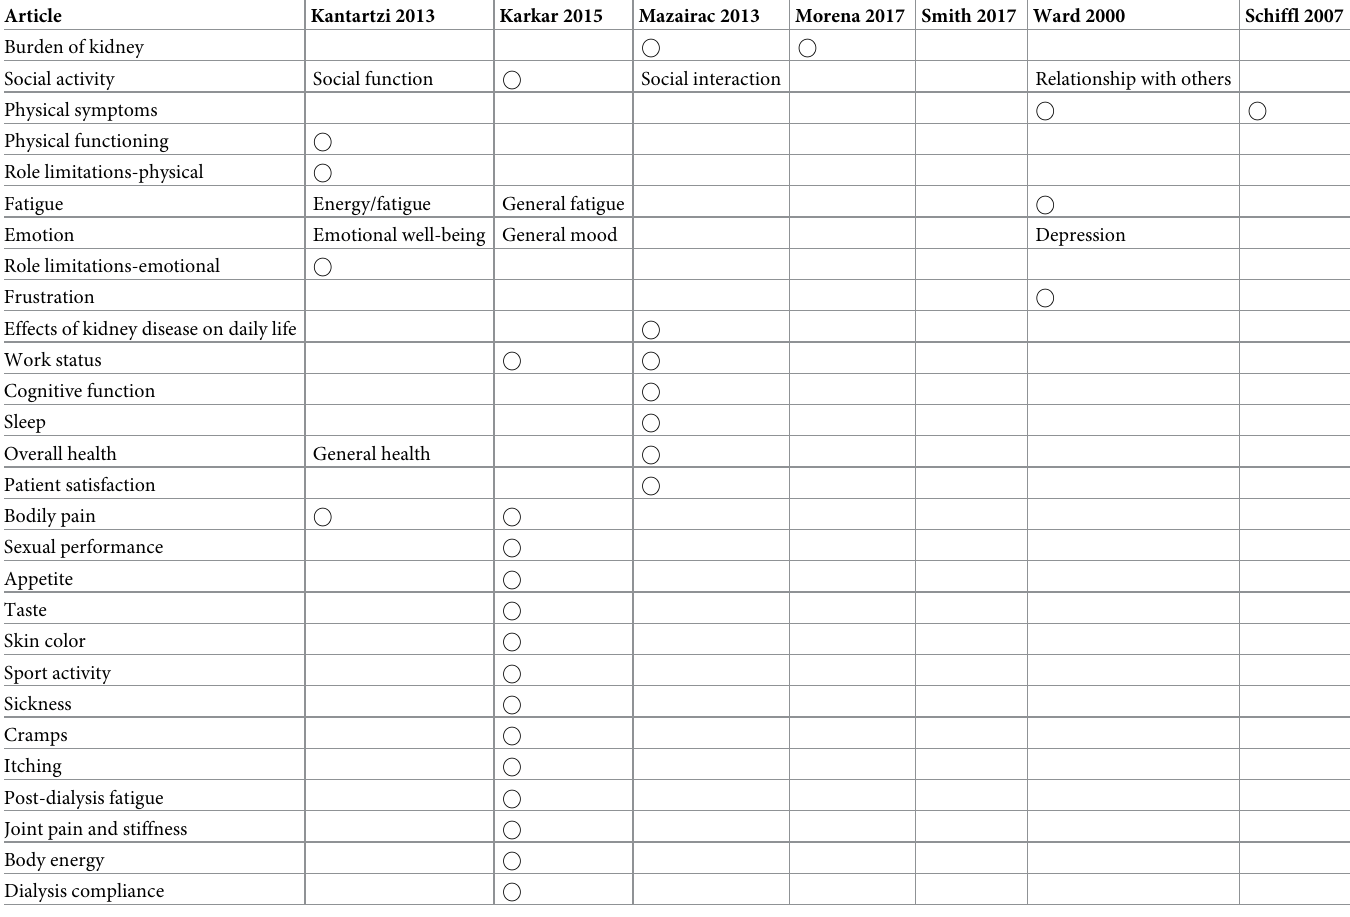
Table 2. Other scales of QOL except for PCS and